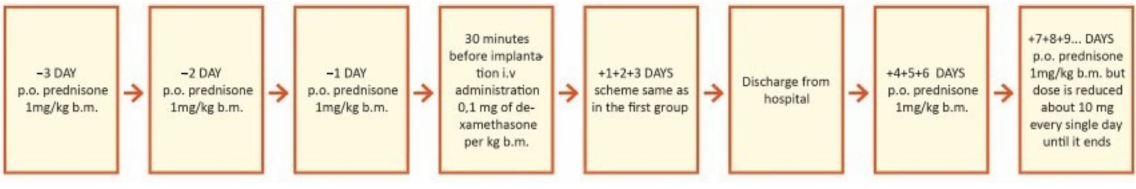
Figure 3. Study design for second group, treated with combined oral and intravenous (iv) steroid therapy (prolonged therapy). p.o.—per oral; i.v.—intravenous; b.m.—body mass = body